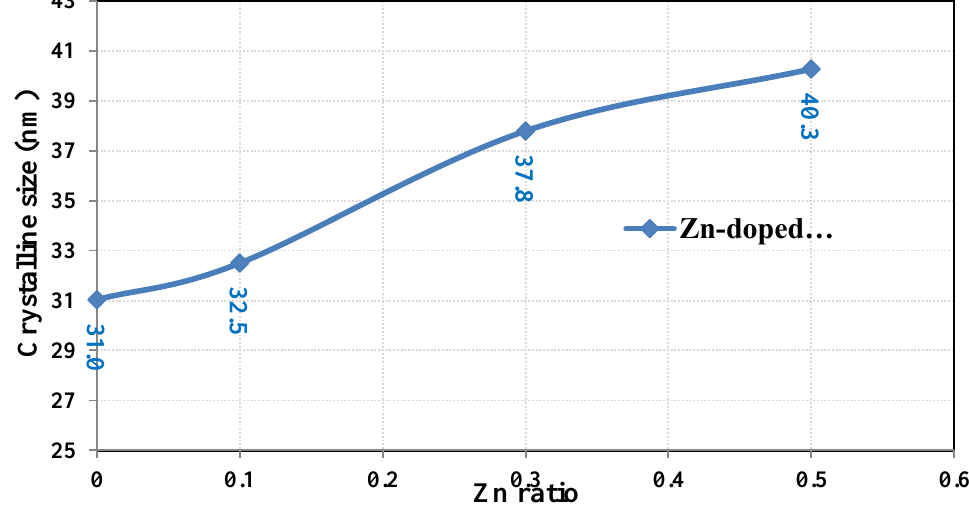
Figure 2: Variation of crystalline size for the preferred orientation with Zn ratio for (111) direction.